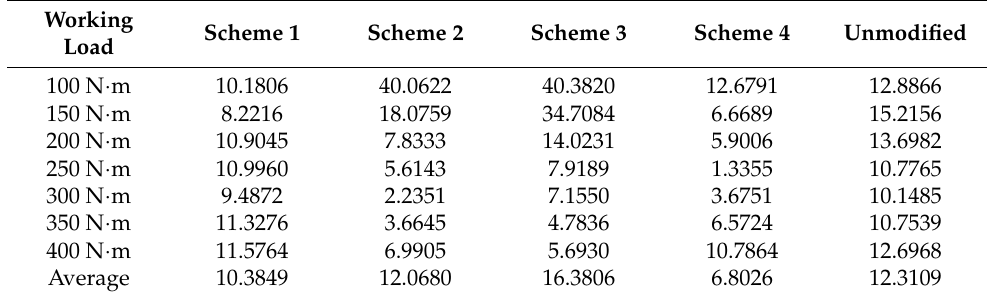
Figure 26. Vibration acceleration in the direction of the gear meshing line at a load of 400 N·m. Table 4. Root mean square value of vibration acceleration in the direction of the meshing line under different working loads (m/s 2 ).